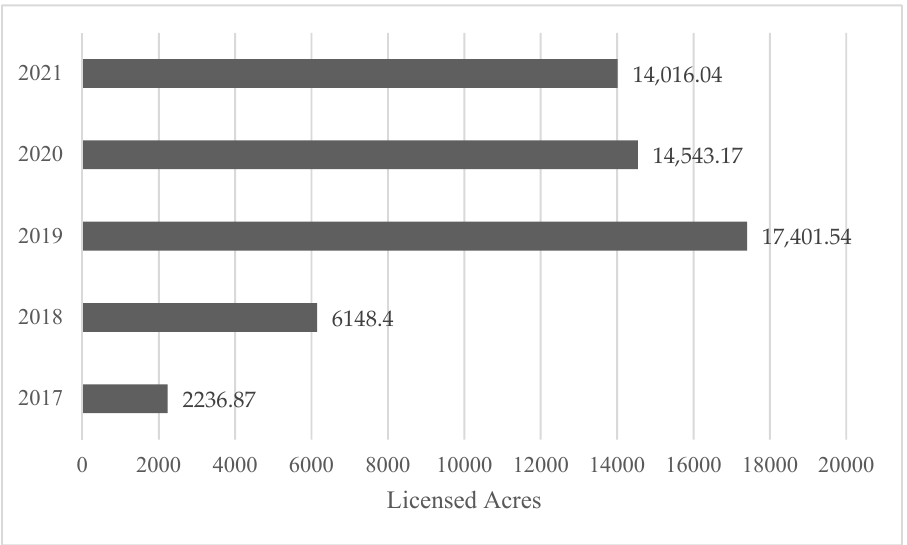
Figure 3. Licensed Hemp Acres in NC, 2017–2021. Source of data: NC Department of Agriculture.